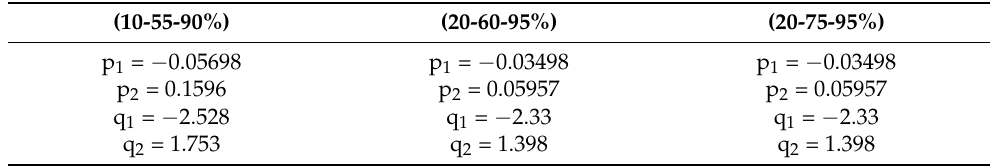
Table 8. Parameters {p i , q i } of the rational function f 2 ( α ) for the different sets of asymmetrical points. Note that the parameters for (20-60-95%) and (20-75-95%) are the same since their x 1 and x 3 -values are the same (x 1 = 20% and x 3 =